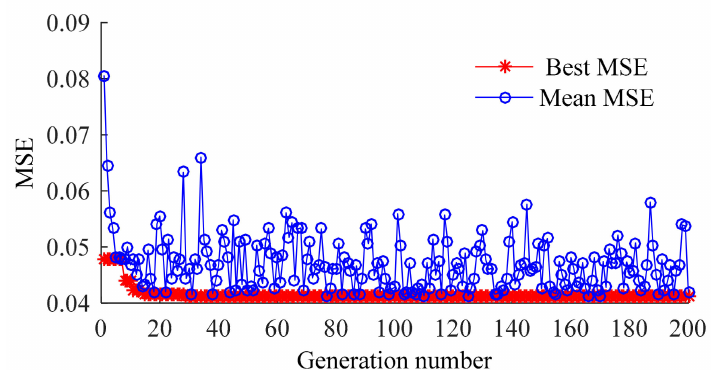
Figure 12. Iterative optimization process of GA.